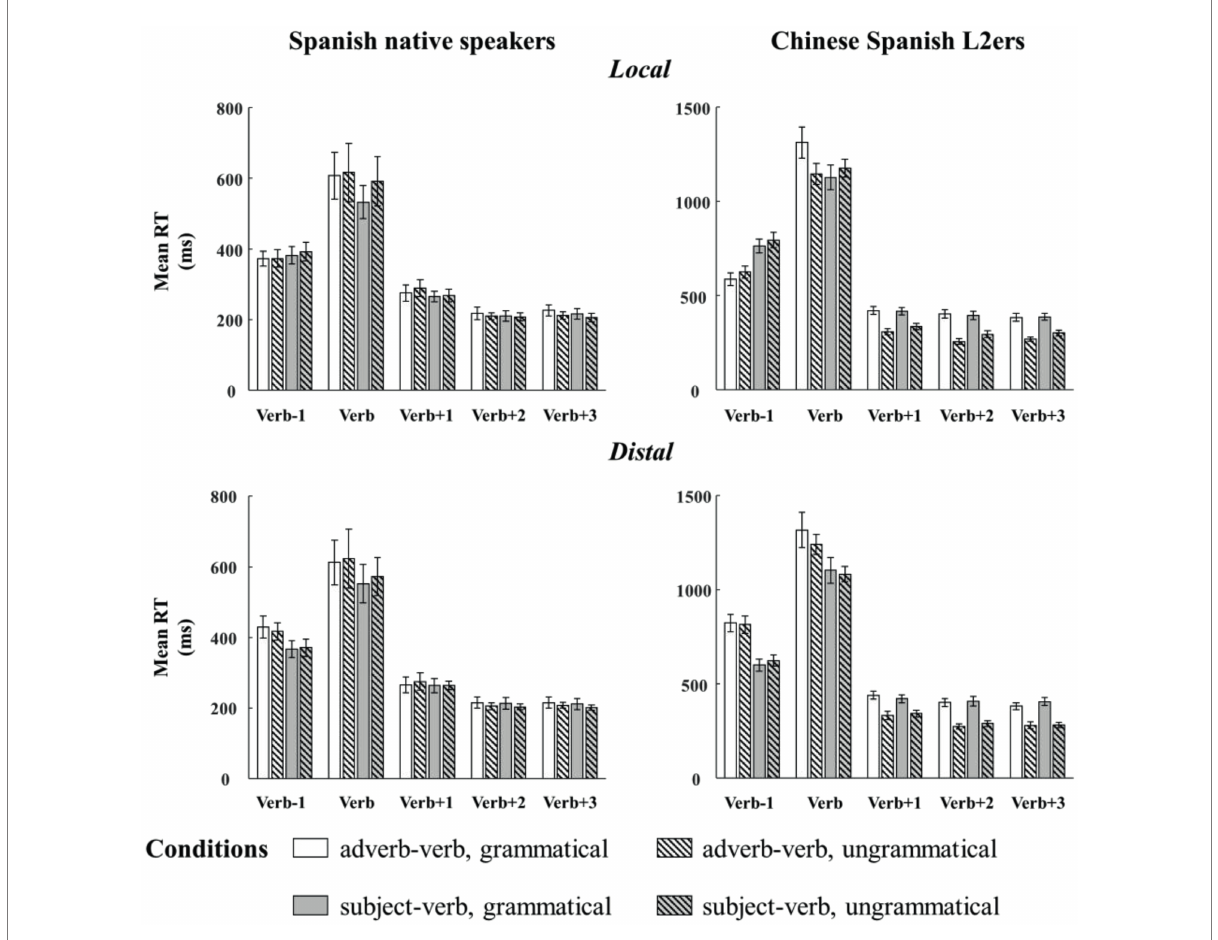
FIGURE 2 Bar plots of mean RTs (and by-subject standard errors) to adverb-verb TC and SV agreement in the two configurations from native Spanish speakers and Chinese Spanish L2ers. Mean RTs were divided into five regions: the target verb, one preceding word, and three following